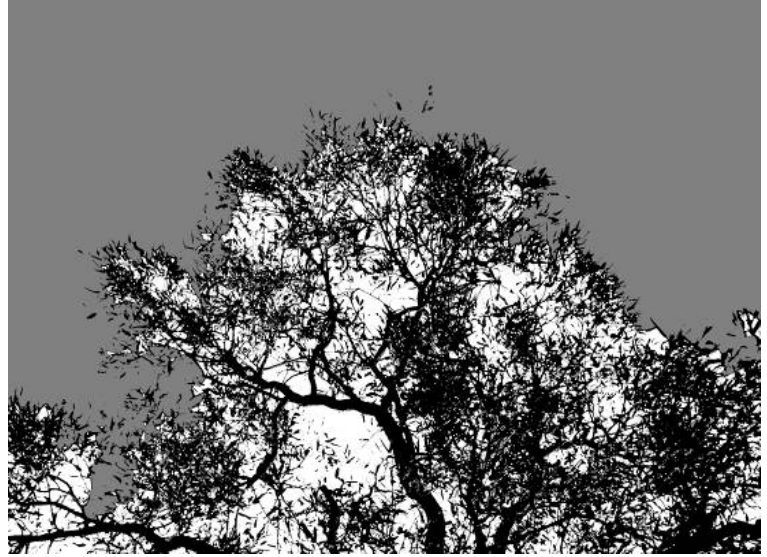
Figure 2. Example of a cover image that has been classified into canopy (black), small within crown gaps pixels (white) and large between-crown gaps (grey). Crown cover (0.51) is the fractional cover of black+white pixels. Foliage cover (0.29) is the fractional cover of black pixels. Crown porosity (Equation 1) is the ratio of white to black+white pixels